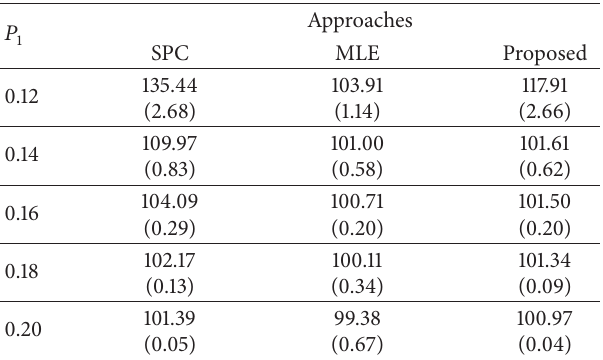
Therefore, UCL = 19, CL = 10, and LCL = 1. Observing Figure 1, it is apparent that the change point (i.e., at time 101) is not equal to 𝑛𝑝 chart’s signal (i.e., at time 138).